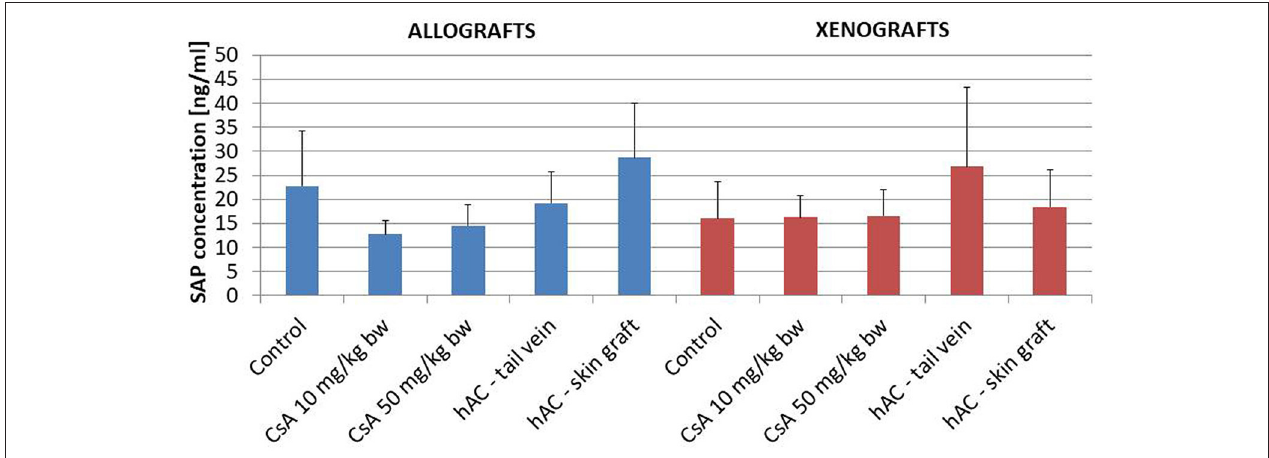
FIGURE 4 | The results of Schilling test expressing the percentage of leukocytes in the mouse blood of studied groups. Blood smears were performed on the last day of the observation for each animal. The average values are presented in the graph; n = 10.